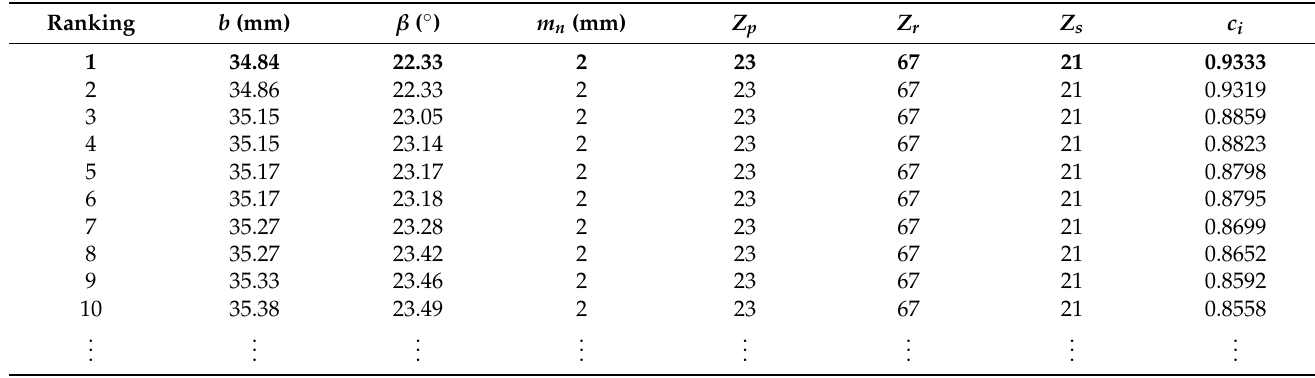
Table A4. Optimization results from MUOD (Case